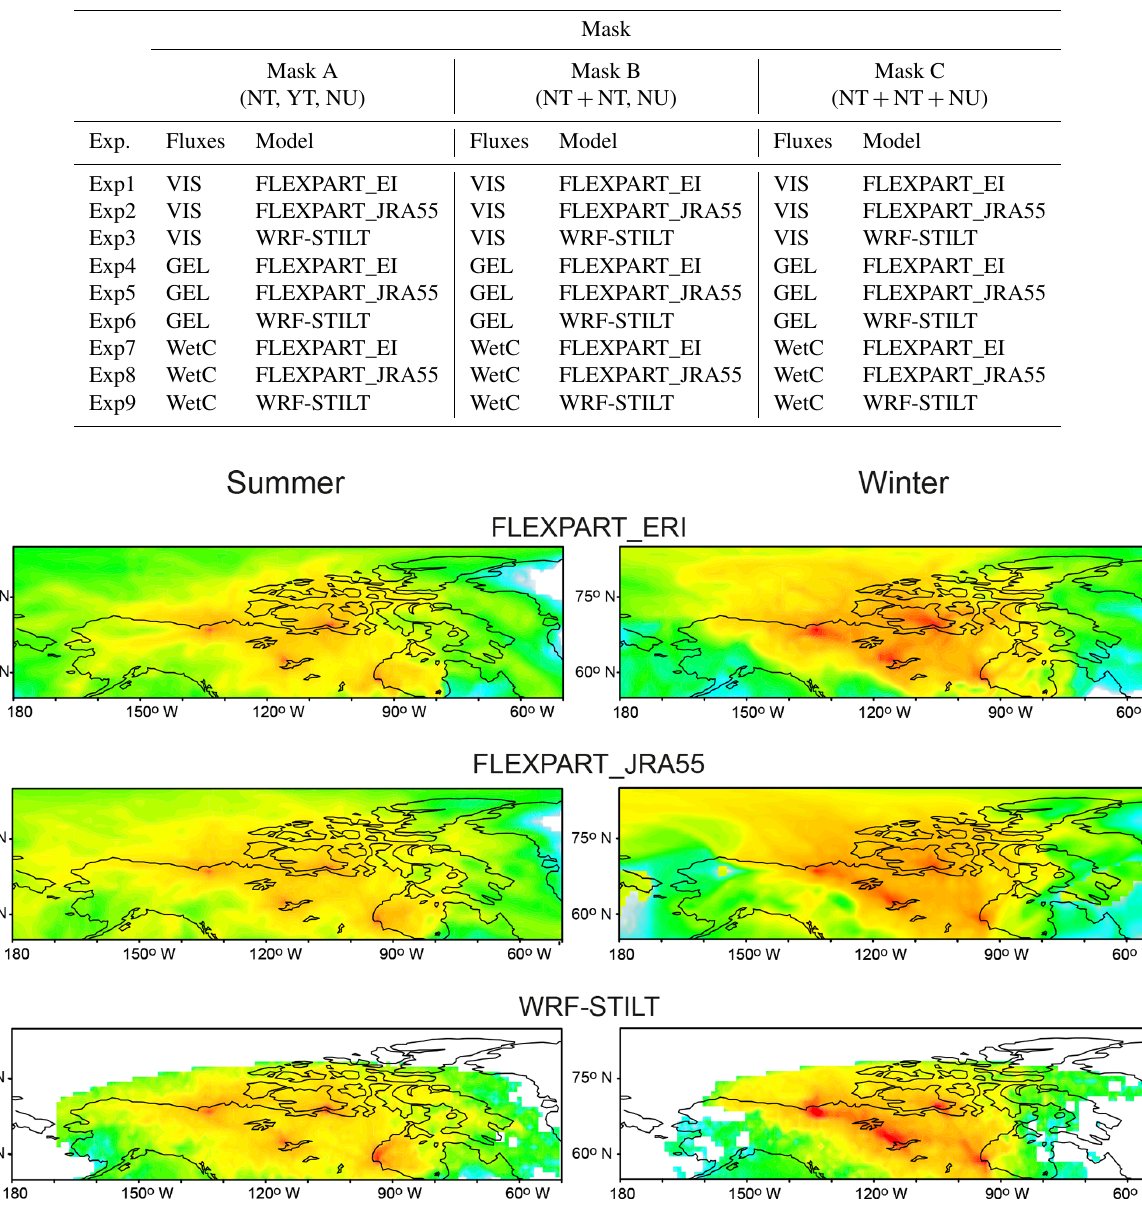
Table 3. Experiment configurations. Using each of three different masks (A, B, and C in Fig. S3), nine inversion runs were conducted with a combination of three prior flux cases (VIS, GEL, and WetC on Table 2) and three different models (FLEXPART_EI, FLEXPART_JRA55, and WRF-STILT). In total 27 inversion runs were conducted.